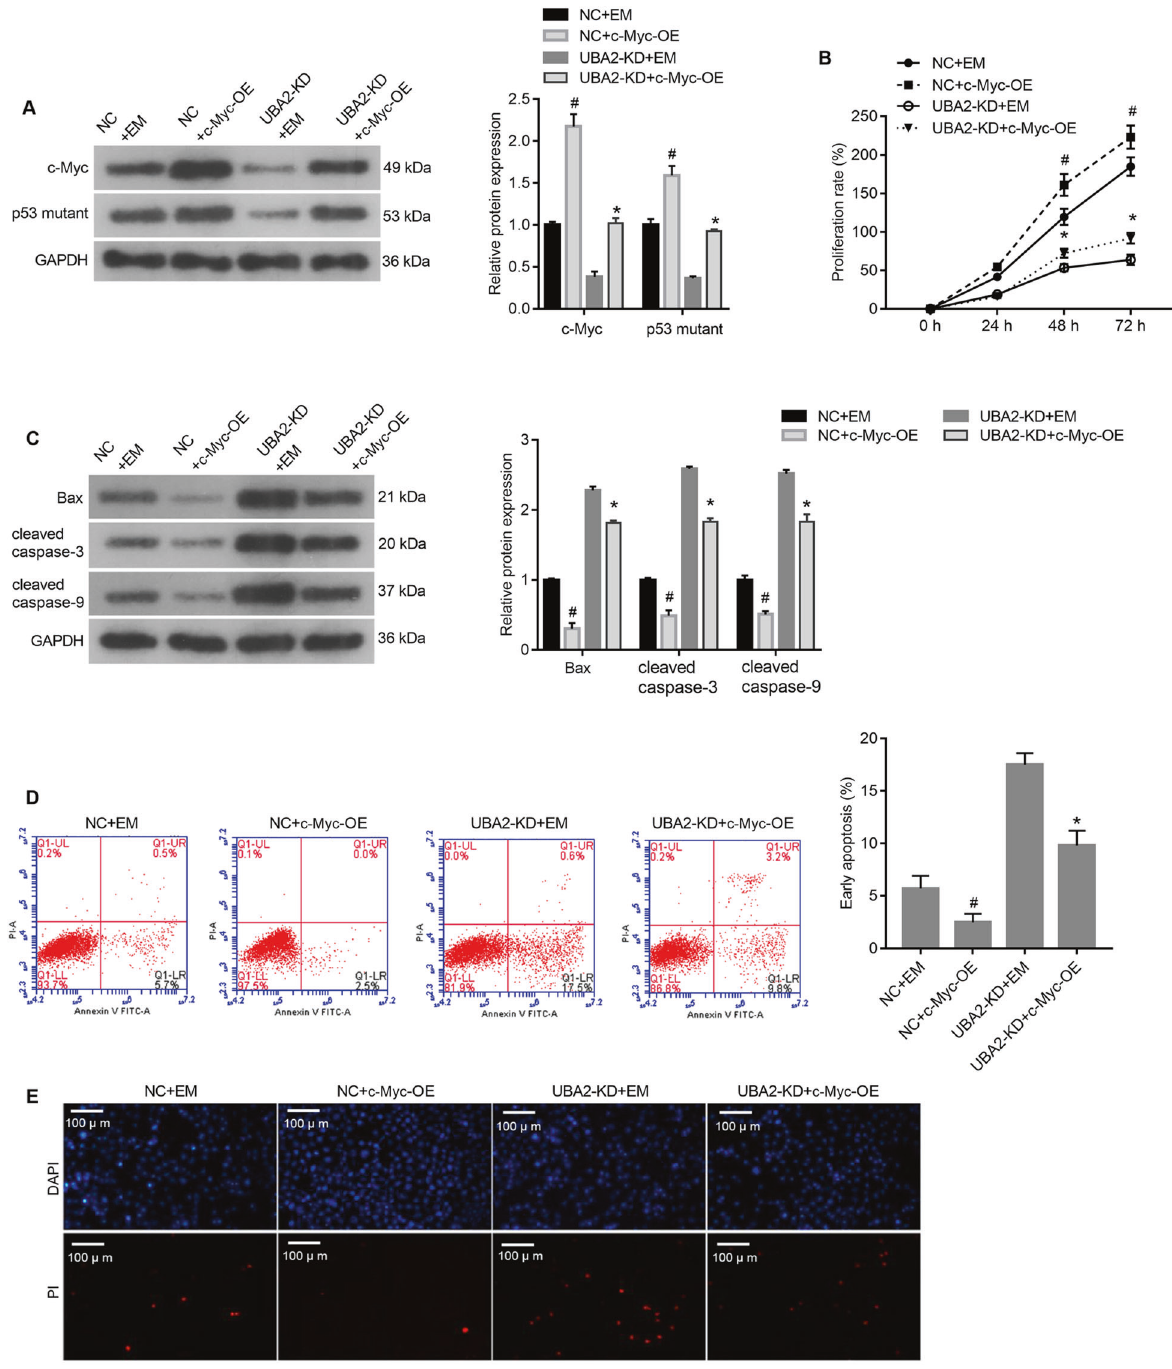
Fig. 6 Alleviation of the effects of UBA2 knockdown on 786-O cell proliferation and apoptosis via overexpression of c-Myc. A Expression levels of the p53 mutant and c-Myc in cells transfected with c-Myc-overexpressing and control plasmids. B Proliferation rates of cells in ( A ). C Expression levels of proapoptotic proteins in cells in ( A ). D Proportions of apoptotic cells in the populations of cells in ( A ). E PI staining of cells in ( A ). # p < .05 NC + c-Myc-OE vs. NC + EM; * p < 0.05 UBA2-KD + c-Myc vs. UBA2-KD + EM. DAPI 4 ′ ,6-diamidino-2-phenylindole, PI propidium iodide, OE overexpression, KD knockdown, NC negative control, mp53 p53 mutant, EM empty vector. cells. This suggestion was supported by the fi ndings that UBA2 loss-of-function assays showed that overexpression of UBA2 knockdown inhibited the proliferation of a ccRCC cell line, while inhibited while UBA2 knockdown promoted cell apoptosis. These UBA2 overexpression promoted cell proliferation. Moreover, our results were also con fi rmed in a nude mouse model of results are supported by those obtained by Kessler et al. [17], who subcutaneous tumor formation. The in vitro and in vivo results showed that the depletion of UBA2/SAE2 signi fi cantly inhibited suggested that UBA2 might play a role in suppressing apoptosis the growth of c-Myc-dependent SUM159 and MDA-MB-231 breast during ccRCC progression, and thus, inhibiting UBA2 expression cancer cell lines. may be a strategy to prevent the malignant proliferation of cancer Cell Death and Disease (2021)